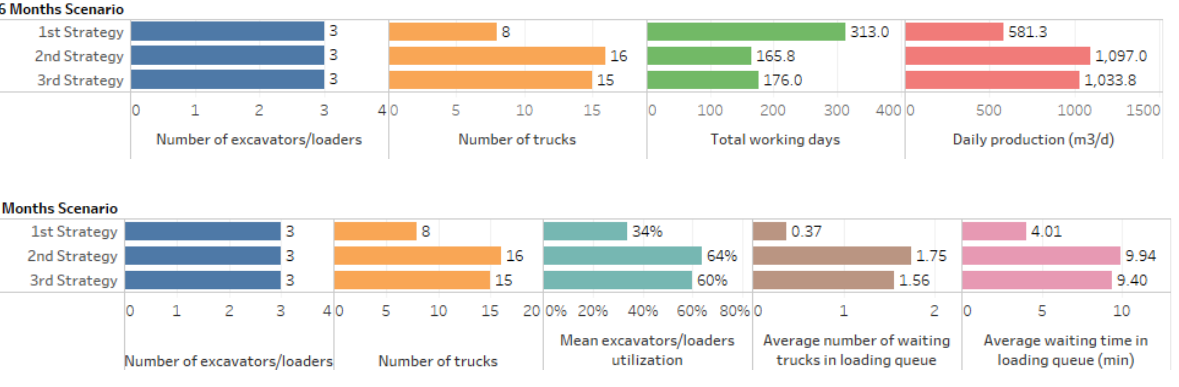
Figure 9. Simulation results of the various strategies for scenario #2. Similarly, various strategies were simulated for the third scenario with 4 months’ (120 days) duration to evaluate the best strategies. For brevity, only the final results of the implemented strategies are reported in Figure 10.